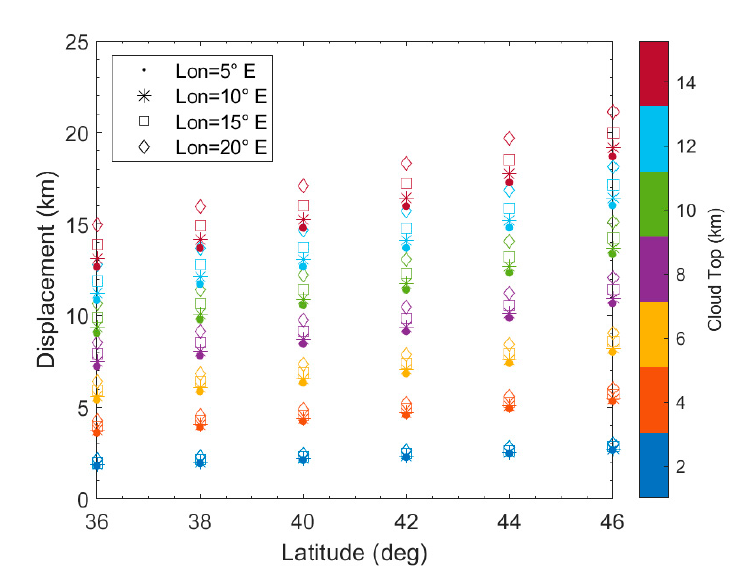
Figure 2. Parallax displacement as function of latitude, longitude, and cloud top height.